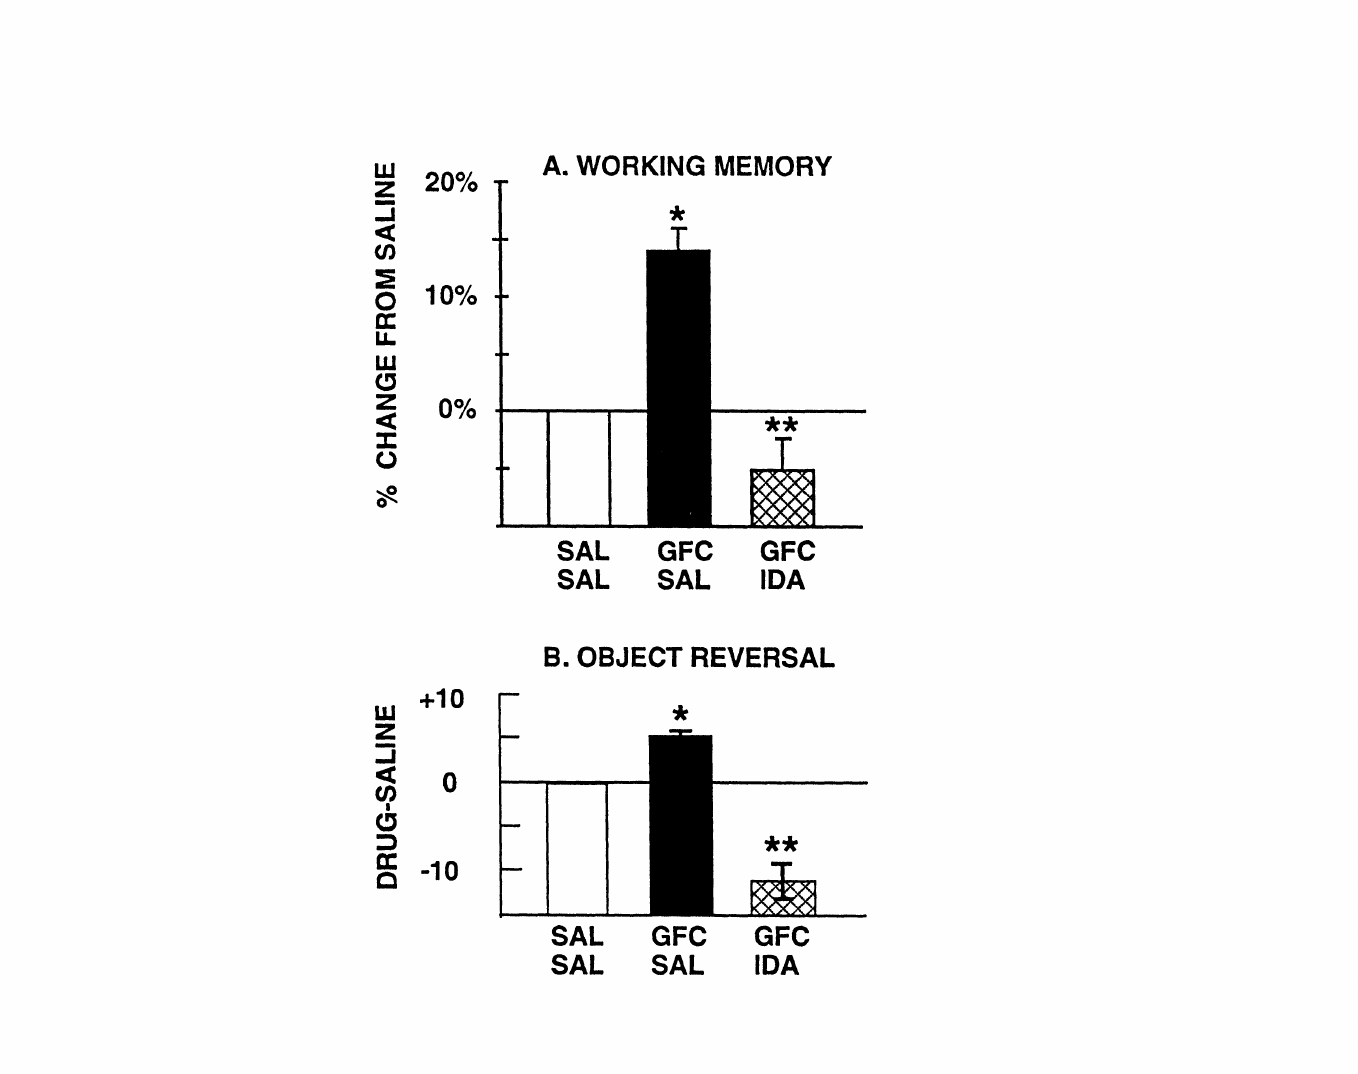
Fig. 3:Alpha-2 receptor stimulation enhances working memory and response-inhibition functions of the PFC. A. The alpha-2A agonist, guanfacine, improves spatial working memory performance in aged monkeys. The improvement with guanfacine is reversed by the alpha-2 antagonist, idazoxan (adapted from Arnsten et al.,